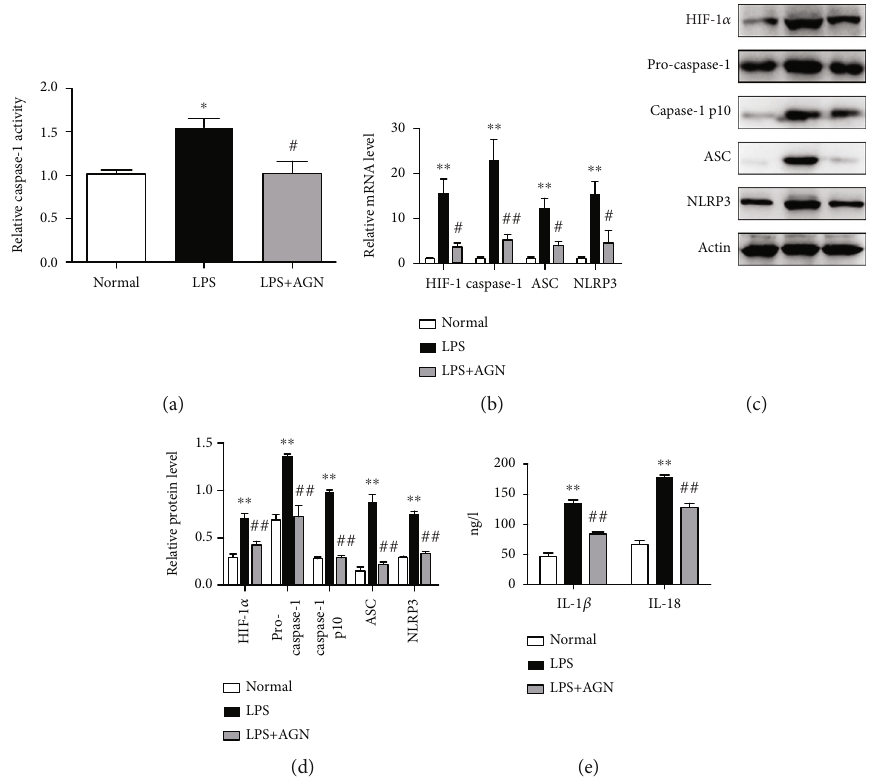
Figure 4: Agnuside inhibits HIF-1 α accumulation and NLRP3 in fl ammasome activation in LPS-treated FLSs. (a) Relative caspase-1 activity for each group. ∗ P < 0 : 05 , in comparison with the normal group. # P < 0 : 05 , in comparison with the LPS group. (b) mRNA level of HIF-1 α , caspase-1, ASC, and NLRP3 in each group. ∗ P < 0 : 05 , ∗∗ P < 0 : 01 , in comparison with the normal group. # P < 0 : 05 , ## P < 0 : 01 , in comparison with the KOA group. (c) Typical protein bands for each group. (d) Protein level comparison of HIF-1 α , pro-caspase-1, caspase-1 p10, ASC, and NLRP3 between groups. ∗∗ P < 0 : 01 , compared with the normal group. ## P < 0 : 01 , compared with the KOA group. (e) FLS supernatant contents of IL-1 β and IL-18 between groups. ∗∗ P < 0 : 01 , compared with the normal group. ## P < 0 : 01 , compared with the KOA